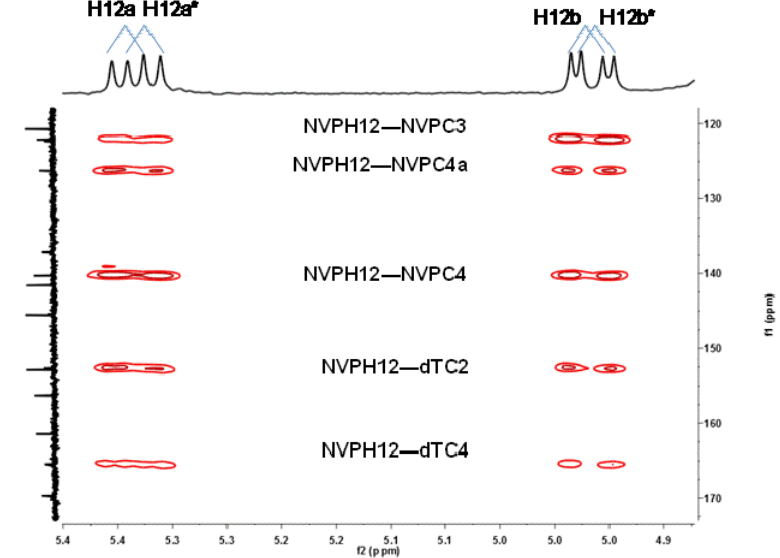
Figure 3. Expanded region of the 1 H- 13 C HMBC spectrum of N3-NVP-dT ( 9 ), recorded in , displaying the connectivities between the geminal NVP-H12 protons and the methanol- d 4 carbons of the NVP (C3, C4, and C4a) and dT (C2 and C4) moieties. The NVP-H12/dT-C2 and NVP-H12/dT-C4 3-bond connectivities were decisive for structural assignment.